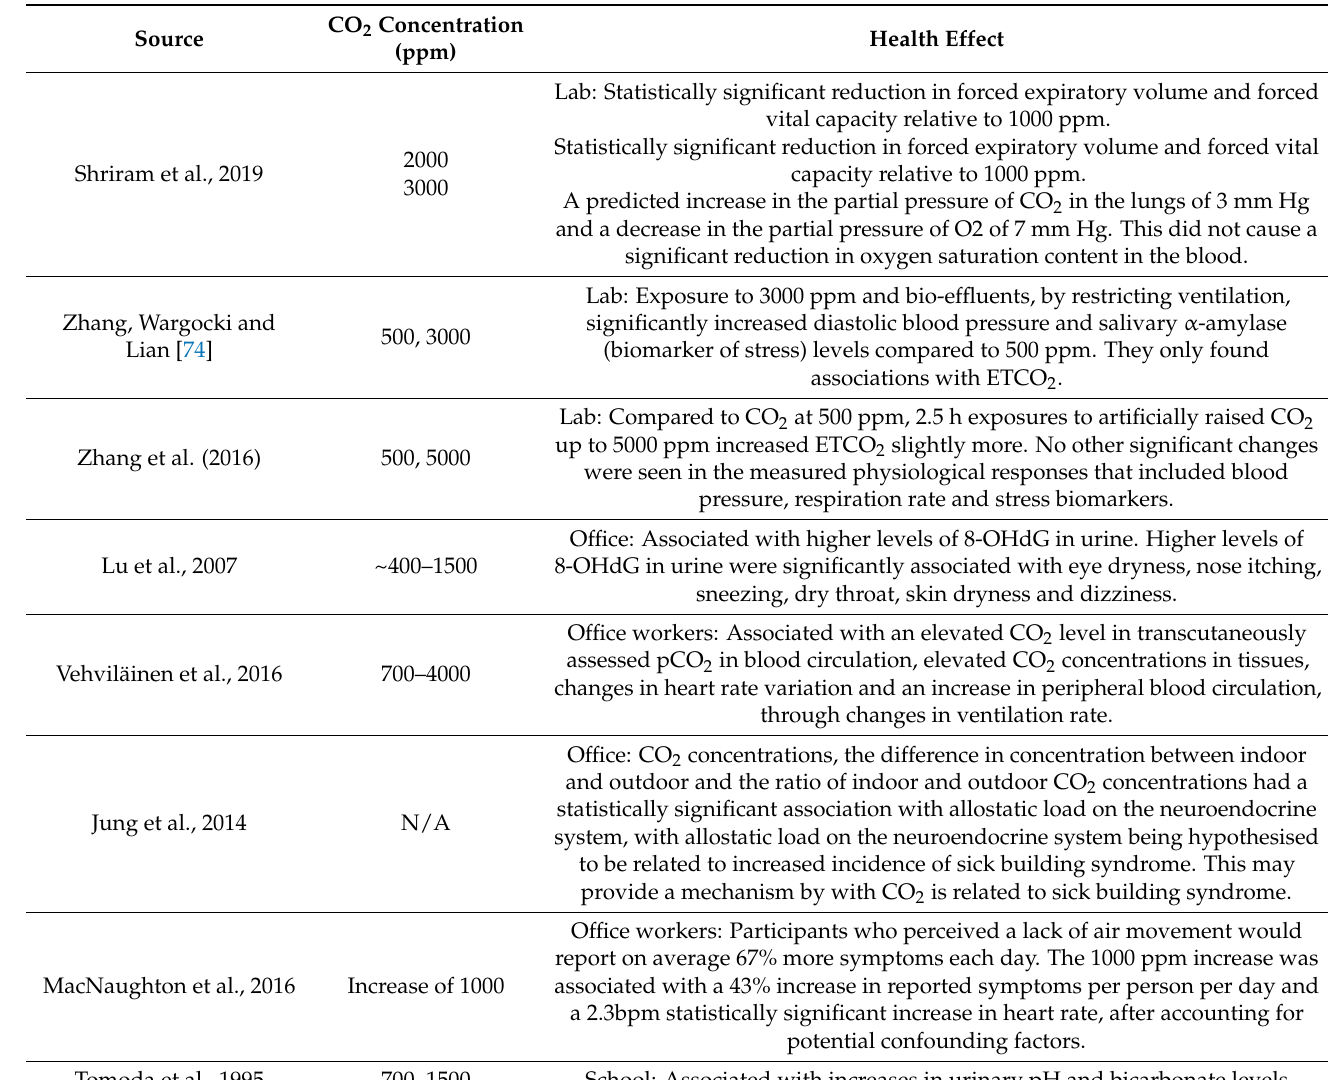
Table A5. A summary of primary research associating CO 2 with human physiological responses.